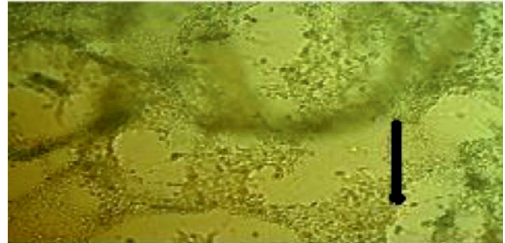
Fig. 4. Tissue culture of chicken fibroblast (Mangifera 10 -1 extract dilution) influenza virus inoculation, very little effect of the virus on the cell (few CPE after 48 hours) comparing with the normal negative control cells.